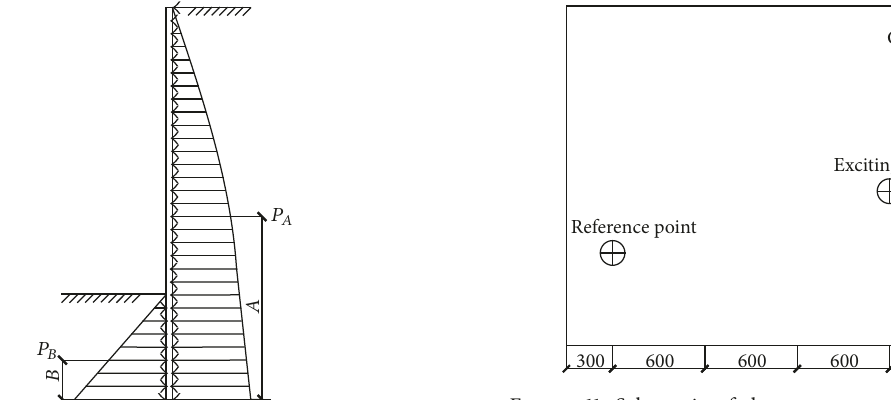
Figure 11: Schematic of the measurement and excitation points (unit: